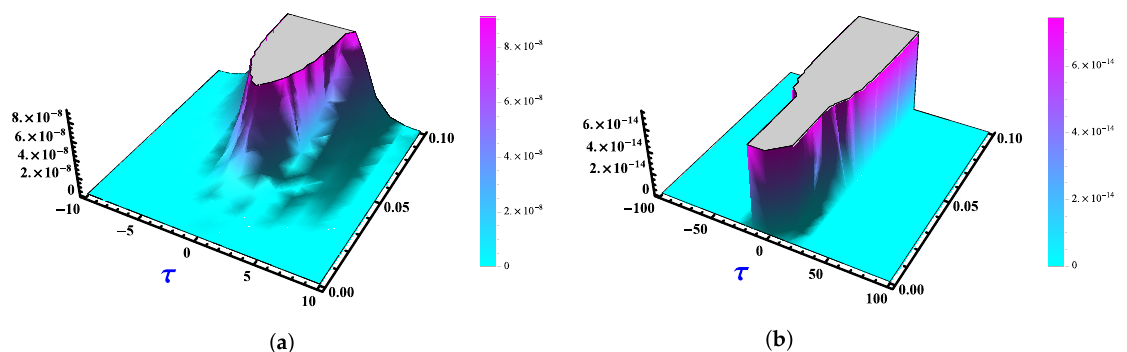
Figure 20. Absolute Error (AE) 3D graph of the obtained numerical solutions by using FNAM verses ( a ) τ ∈ [ − 10,10 ] and ( b ) τ ∈ [ − 100,100 ] at time ξ ∈ [ 0,0.1 ] and k = 1 for Example